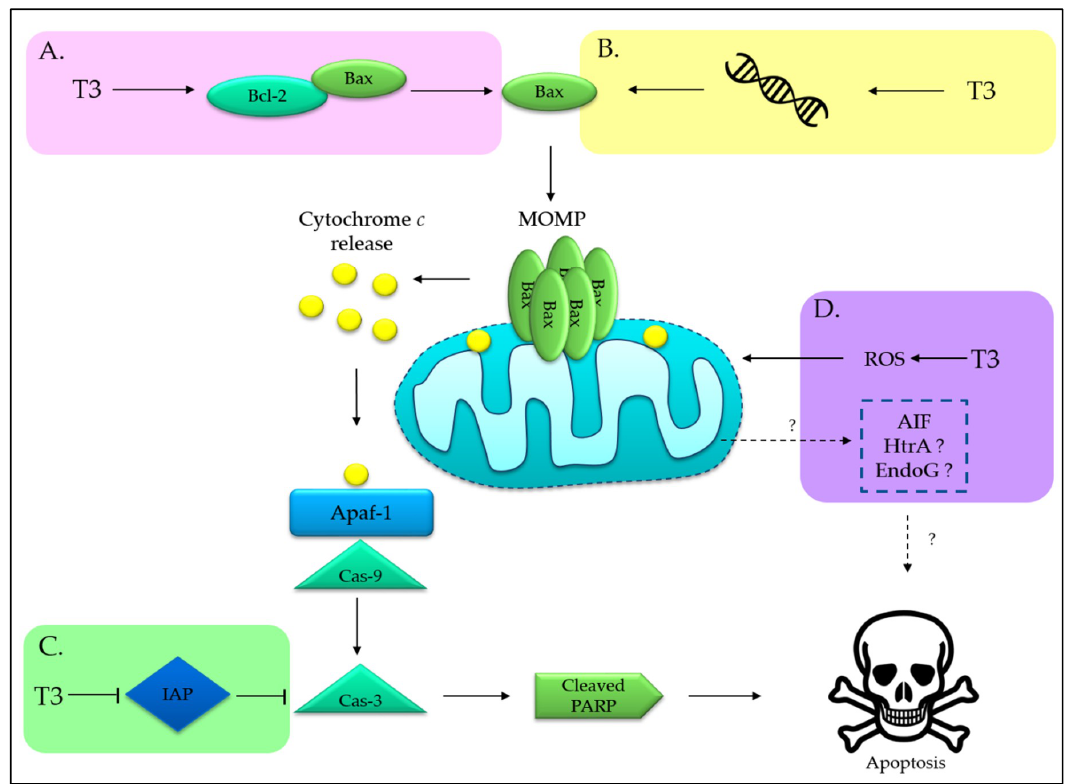
Figure 3. Proposed actions of tocotrienols (T3) in inducing mitochondrial pathway of